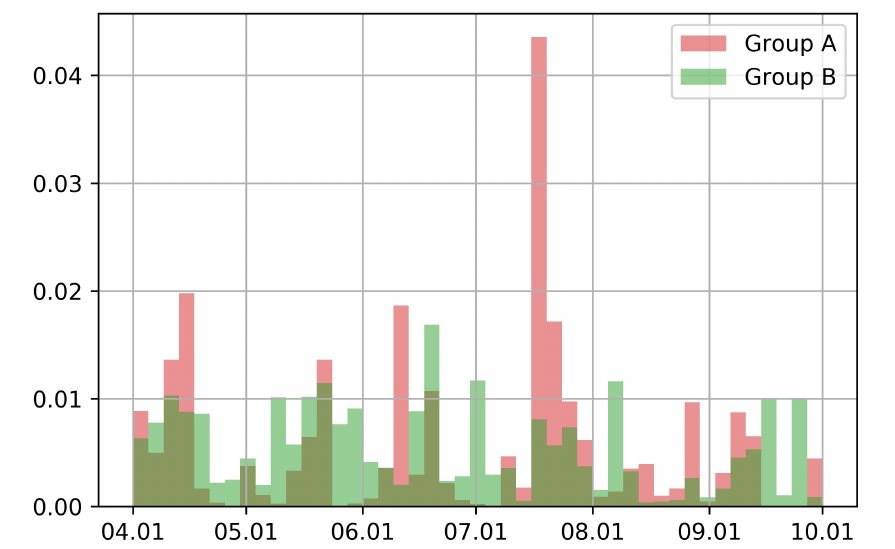
Figure 7. Comparison of queued jobs for two groups in 2019.